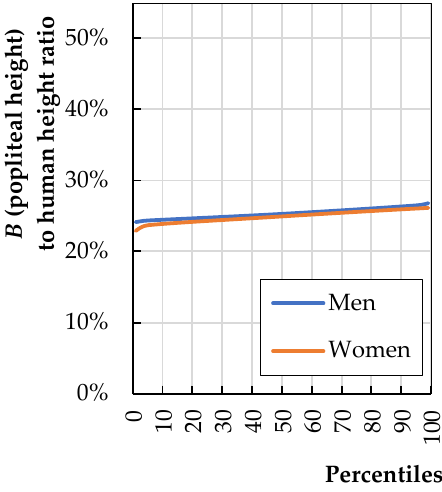
Figure 5. The ratio of buttock-popliteal length ( B ) to total human stature ( H ) (calculations based on literature data [20]).